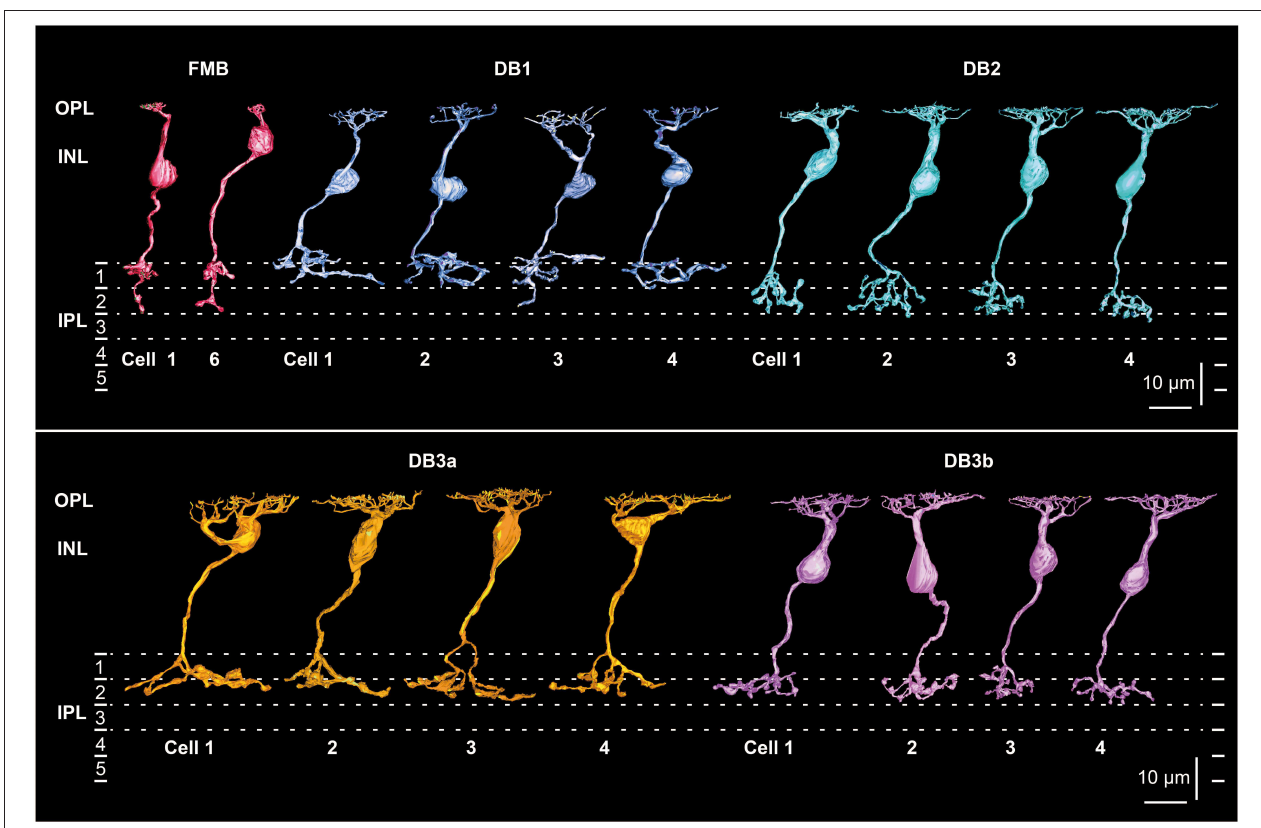
FIGURE 1 | Morphology and stratification of FMB, DB1, DB2, DB3a, and DB3b types of OFF bipolar cells. FMB cell-1 and cell-6 (FMB-1 and FMB-6) are connected to M/L and S cones, respectively. Four cells (1-4) are displayed for each DB type. Each stratum of the IPL (1-5) is 6 µ m thick. Strata 1-2 comprise the OFF